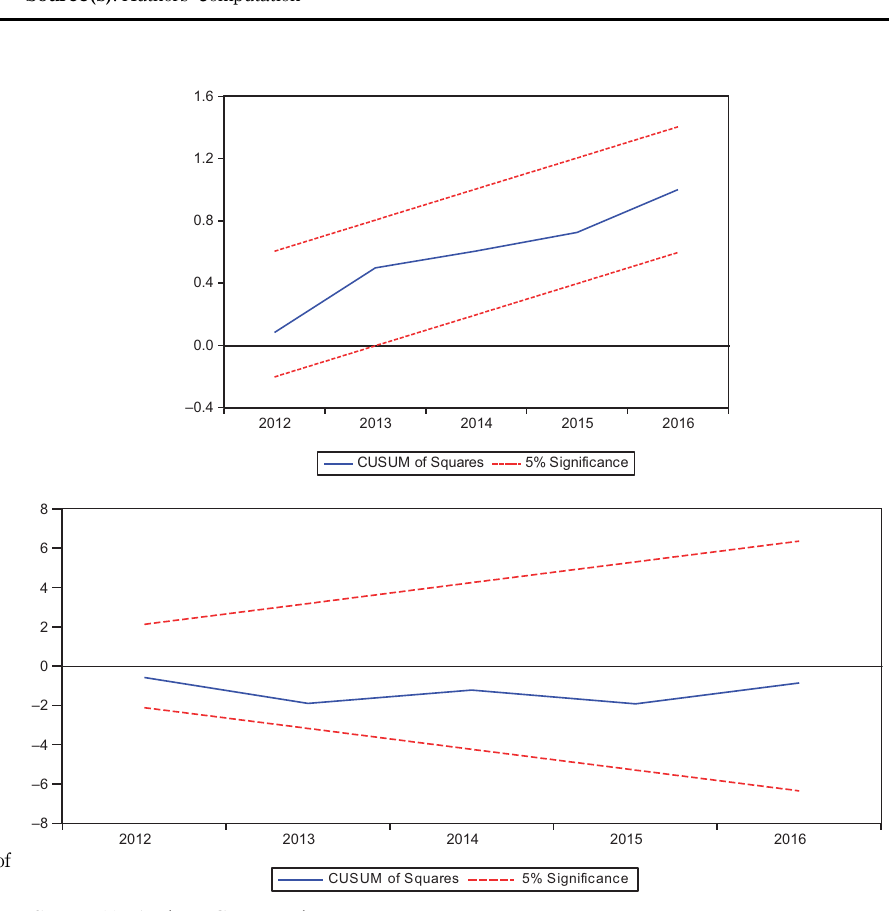
Figure 1. CUSUMandCUSUMof square for model for ARDL